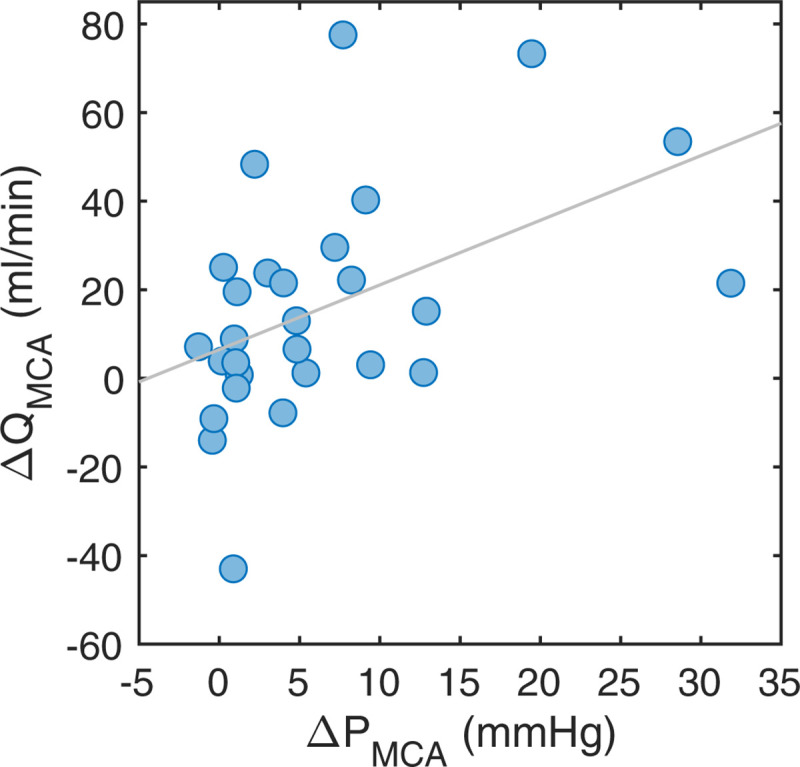
MCA flow relationship to pressure.The ΔQMCA versus the ΔPMCA. The linear correlation was r = 0.47 (p = 0.011).